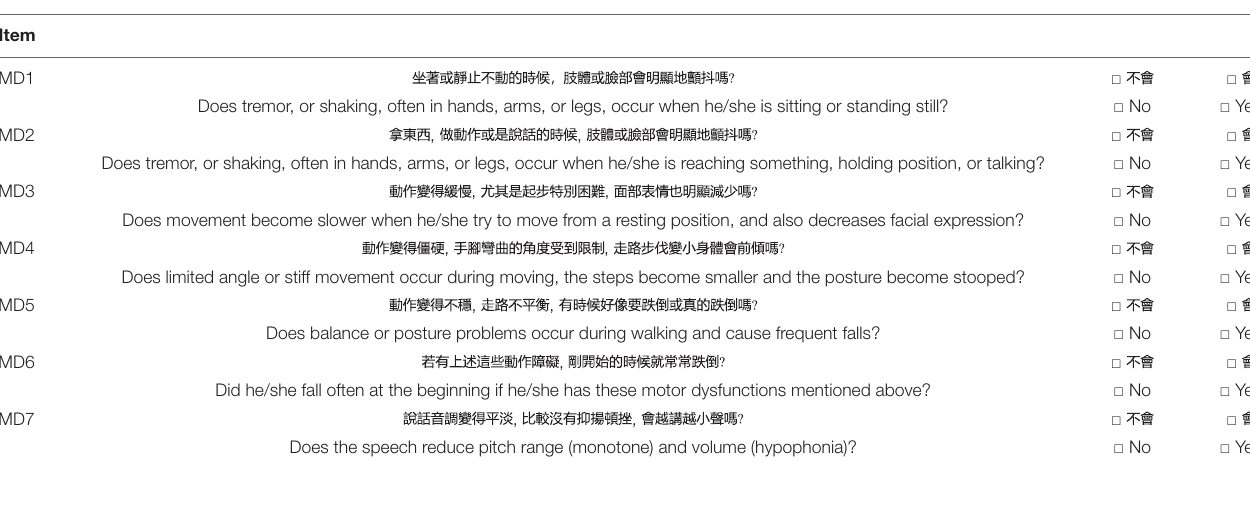
TABLE A1 | Composition of the HAICDDS-Motor Dysfunction Questionnaire (HAI-MDQ).